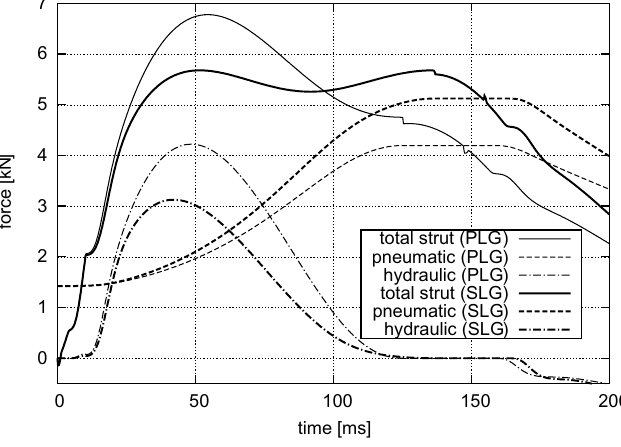
Fig. 12. Comparison of computed pneumatic, hydraulic and total strut forces in PLG and SLG for m = 350 kg and v 0 = 1 . 5 m / s .